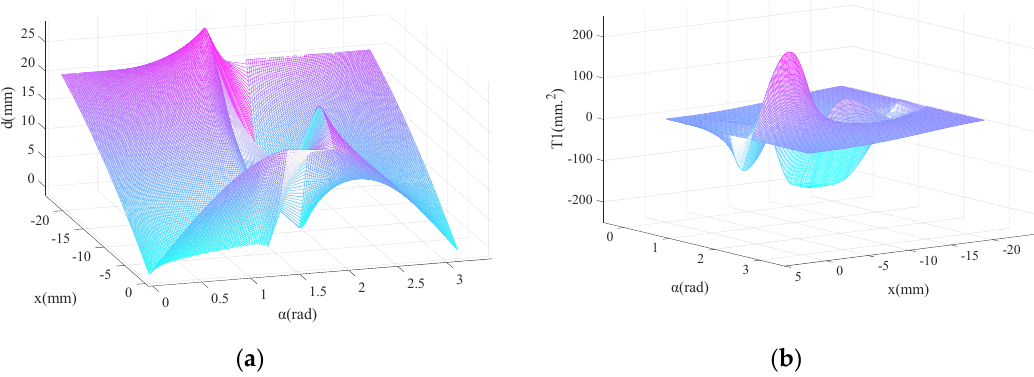
T . Figure 5. ( a ) Moment arm of the hip master cam; ( b ) three-dimensional diagram of T 1 1